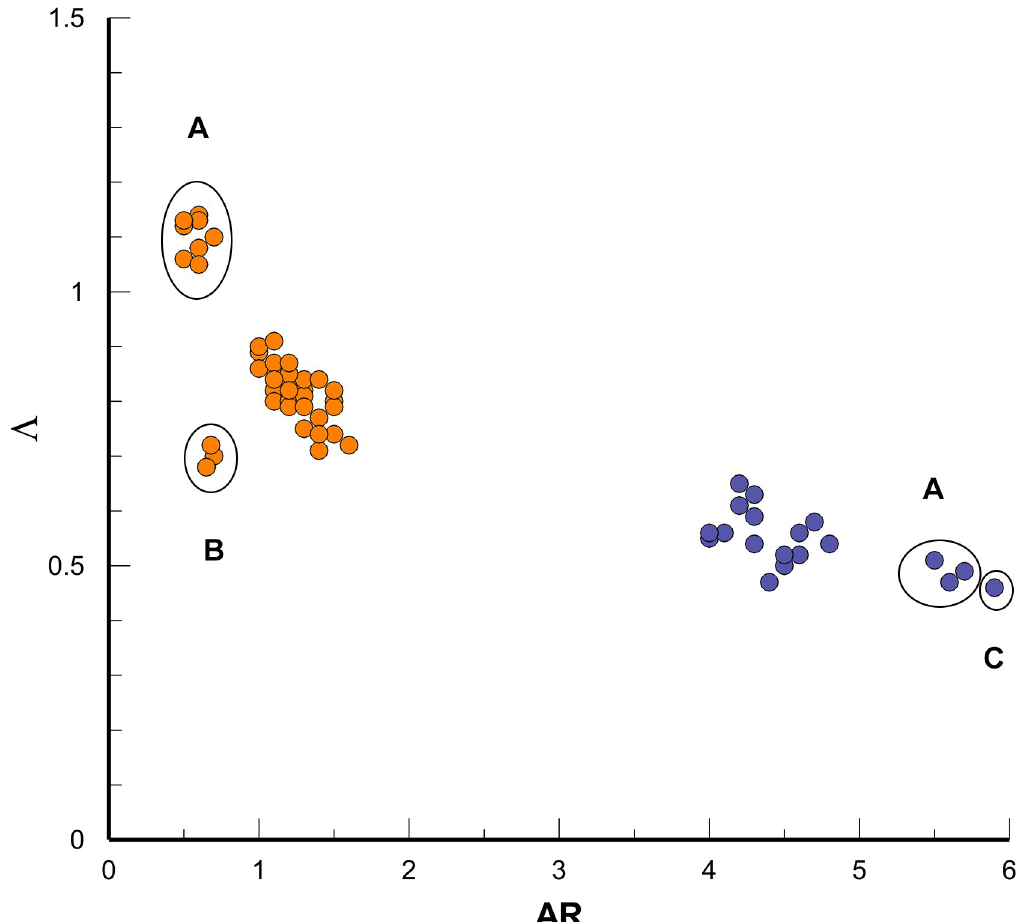
Fig 18. The Λ , in radians vs AR scatterplot shows the fin planform variation in the dorsal fin (orange) and tail flukes (blue). Different variation along the Λ and AR axes indicates two distinctive patterns of the fin planform. A– G . melas , B– P . phocoena , C– B . acutorostrata